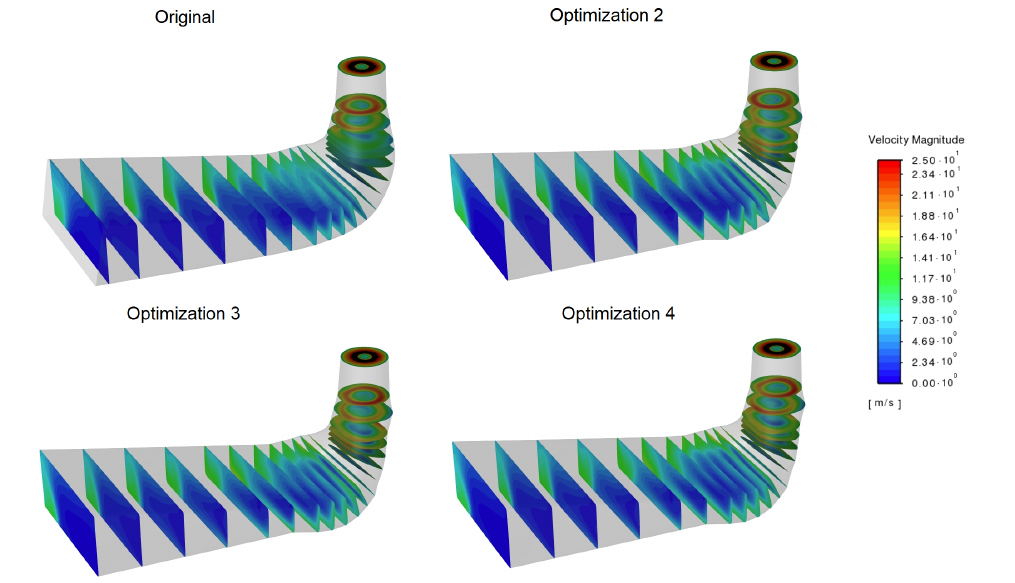
Figure A9. Velocity magnitudes in several draft tube cross-sections for a 14.3 m 3 /s flow